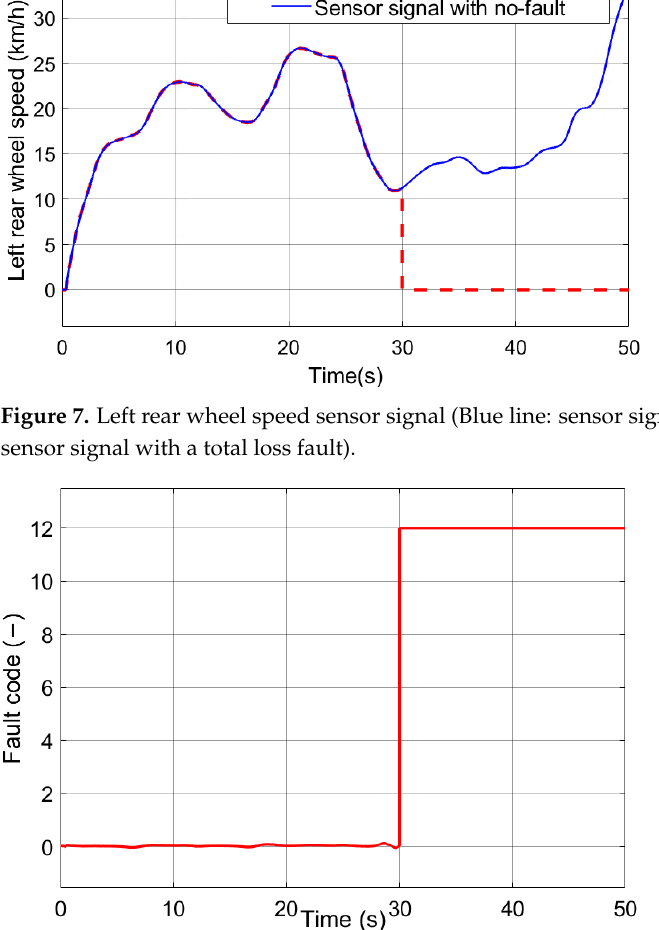
Figure 8. Diagnosis output with a fault code 12, which corresponds to a total loss fault in the left rear wheel speed sensor at 30 s until the